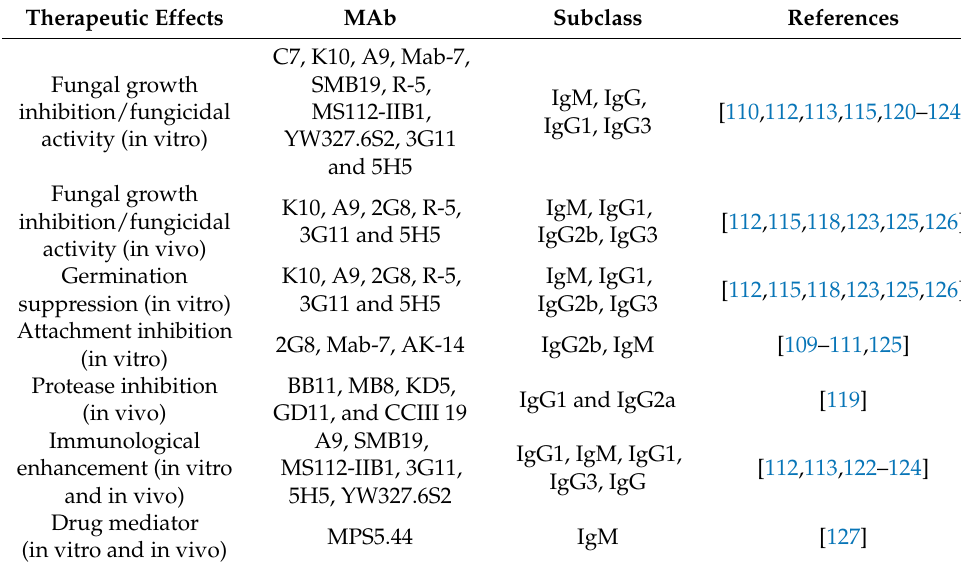
Table 2. Monoclonal antibody-mediated therapeutic effects in Aspergillus infection. Therapeutic